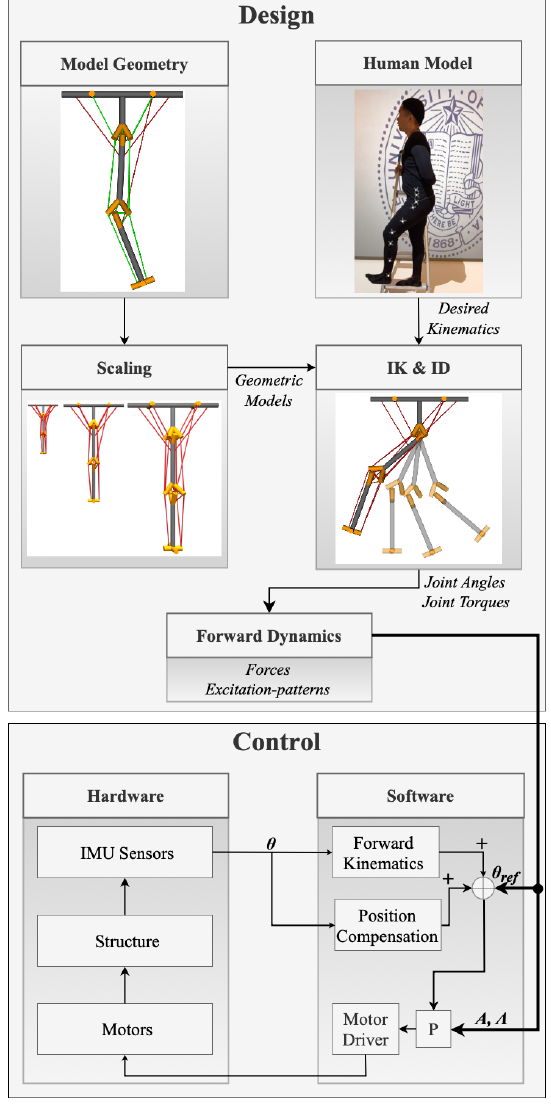
Figure 4. Flowchart illustrating the design